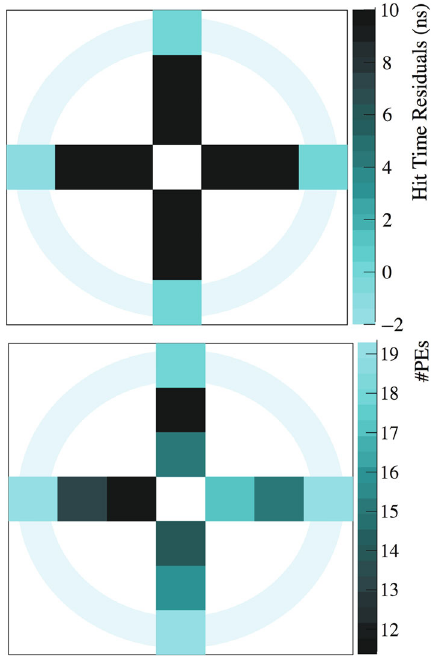
Fig. 5 A single ring candidate event in LAB. (Top) Hit-time residual and (Bottom) number of PE versus PMT position. No hit selection is applied here, i.e. this is prior to application of the t c timing